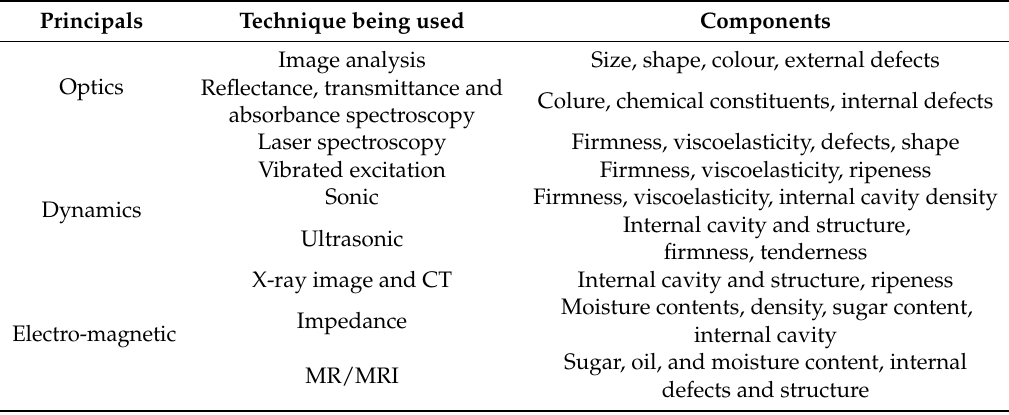
Table 2. Most common non-destructive techniques used to test the quality of agricultural